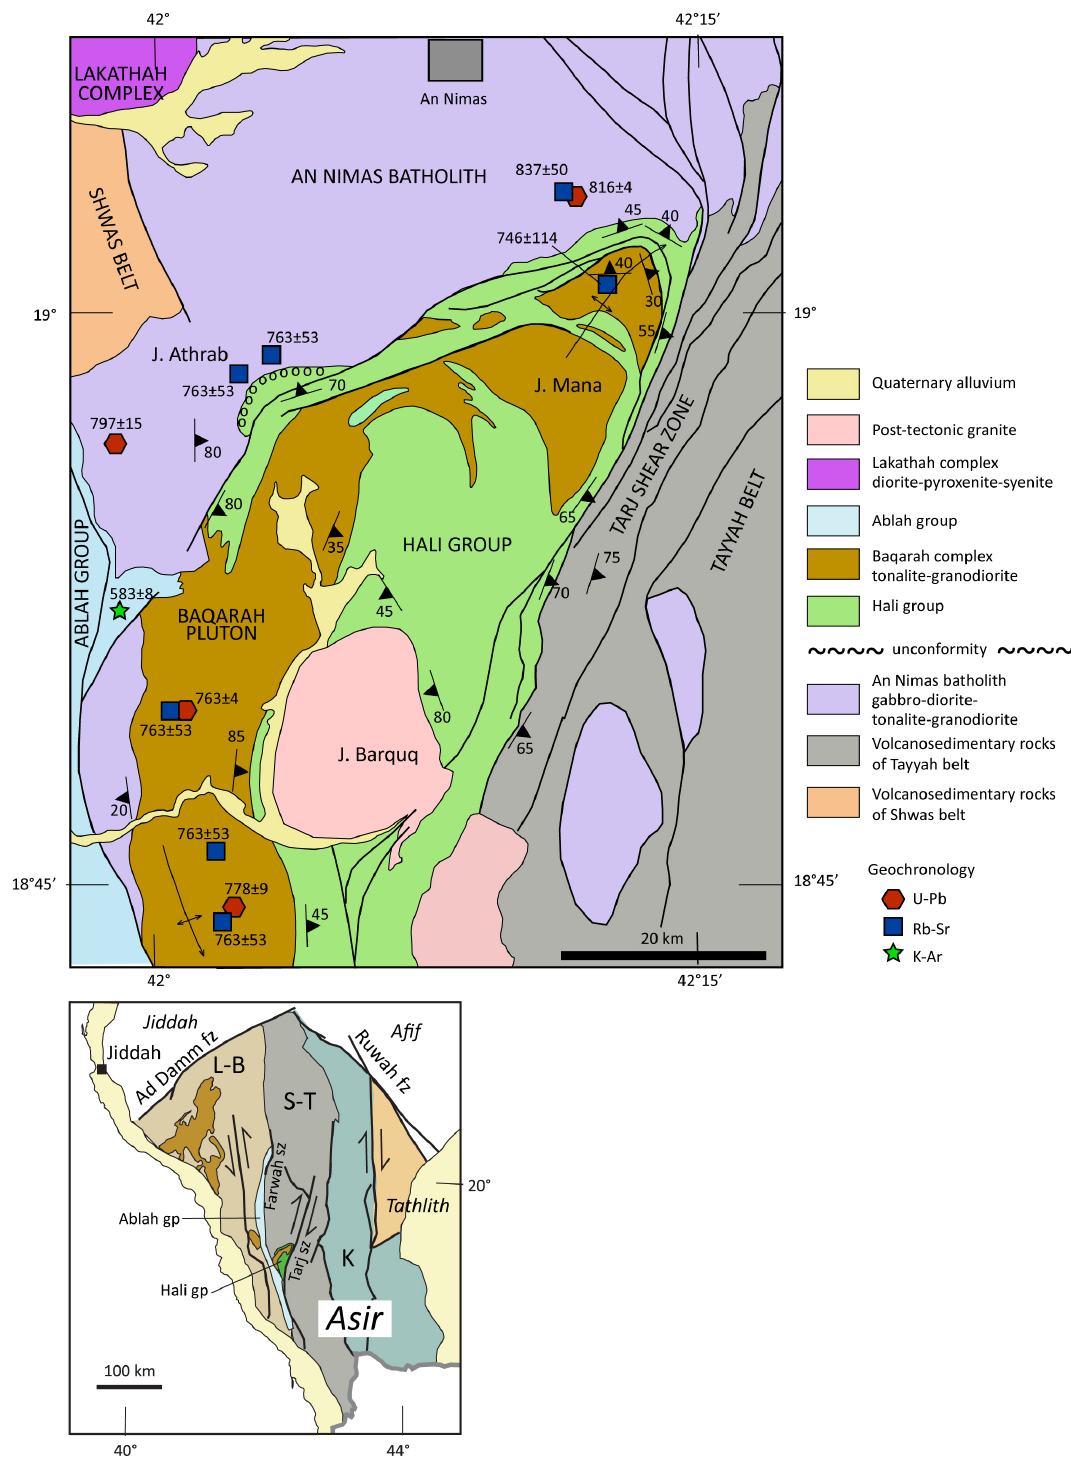
Figure 3. Geologic setting of the Hali group, unconformable on the exhumed and eroded An Nimas batholith (~815–795 Ma) and intruded by ~775–765 Ma syntectonic Baqarah complex tonalite and granodiorite (after [17]). Inset shows the location of the Hali group and younger Ediacaran Ablah group close to and at the junction between the Al Lith-Bidah (L-B) and Shwas-Tayyah structural belts (S-T) in the Asir composite terrane. The Khadra structural belt (K) is a separate belt in the eastern part of the Asir terrane. The Tathlith, Jiddah, and Afif are other terranes east and north of the Asir